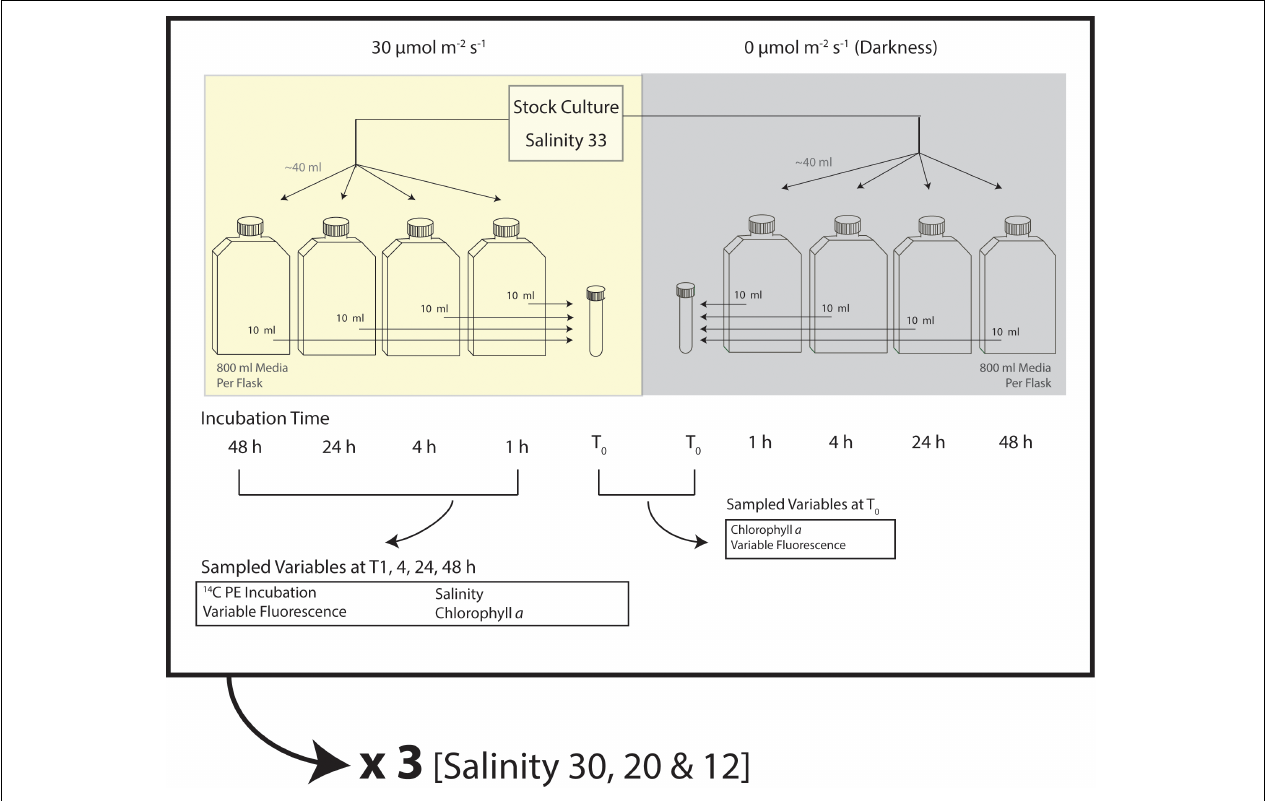
FIGURE 2 | Outline of experimental design for a given treatment of salinities 30, 20, or 12 under 30 or 0 µ mol m − 2 s − 1 , showing analytical measurements at the beginning (T 0 ) of experiments and after 1, 4, 24, and 48